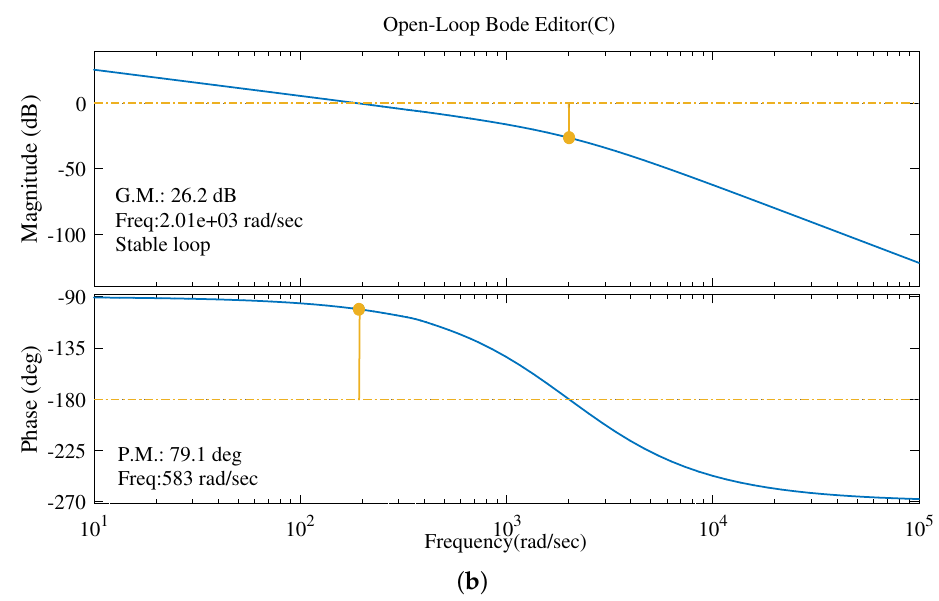
Figure 16. The design results of the controller of the mechanism. ( a ) Pole-zero assignment and root locus correction. ( b ) Open-loop Bode diagram of the system.